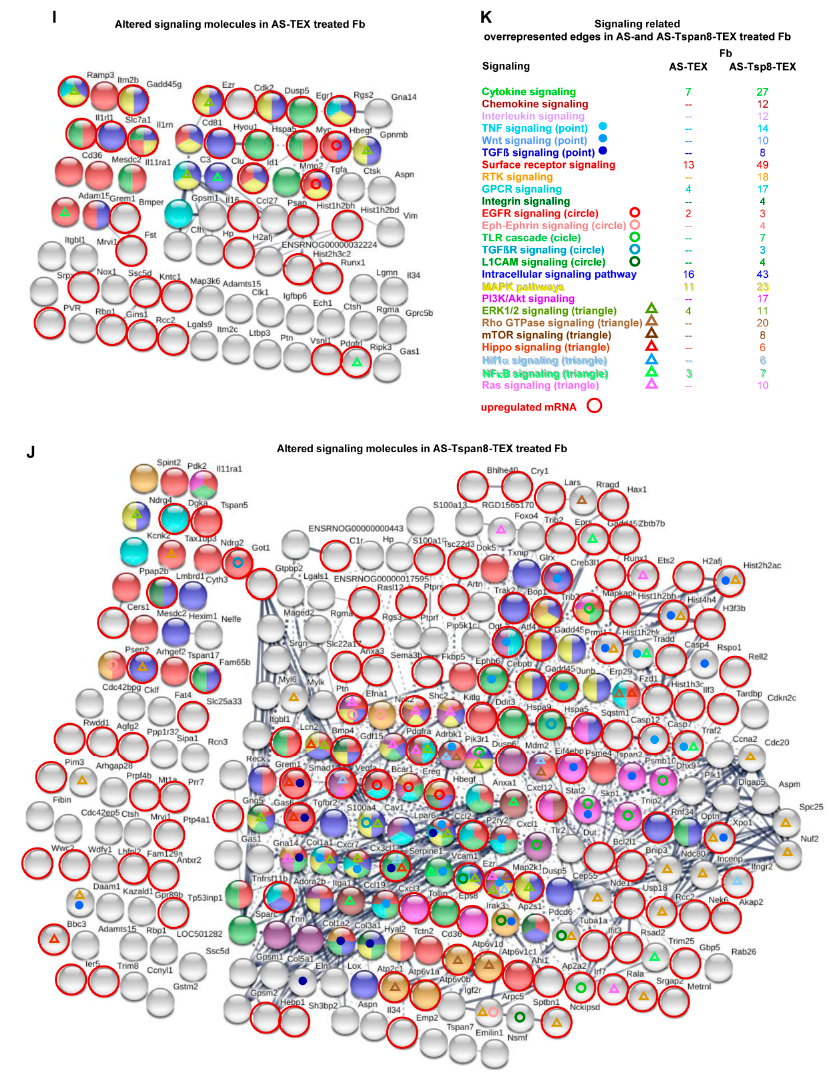
Figure 4. Signaling pathway integration of mRNA up- or downregulated in TEX-treated fibroblasts. mRNA was evaluated in AS- and AS-Tspan8-TEX-treated Fb for up- or downregulation compared to untreated Fb. ( A – D ) STRING functional protein analysis included mRNA with a signal strength ≥ 1000 and ≥ 2-fold di ff erence between untreated and TEX-treated Fb, only connected nodes being shown ( A ) mRNA upregulated in AS-TEX- and ( B ) AS-Tspan8-TEX-treated Fb; ( C ) engagement of overrepresented edges of upregulated mRNA in the regulation of biological processes; ( D ) engagement of overrepresented edges of downregulated mRNA (see Figure S5D) in the regulation of biological processes. ( E ) WB of indicated proteins in untreated, AS- and AS-Tspan8-TEX-treated Fb; ( F ) RTK and non-RTK protein array of Fb and AS-Tspan8-TEX-treated Fb. The mean of duplicates is shown, signal intensity being adjusted to 1 for untreated Fb. A significant increase in signal strength ≥ 1.5-fold is indicated by a grey * and by ≥ 2-fold by a black *; ( G ) Fb were seeded on top of matrigel-coated transwell plates that contained RPMI / 10% FCS or RPMI / 30 µ g / mL AS- or AS-Tspan8-TEX. After 48 h, cells at the lower membrane site were fixed and stained with crystal violet, light microscopy appearance (scale bar: 20 µ m). ( H ) WB of the indicated proteins in Fb, AS- and AS-Tspan8-TEX-treated Fb; ( I – K ) STRING functional protein analysis for signaling engaged molecules up- or downregulated in ( I ) AS- and ( J ) AS-Tspan8-TEX-treated Fb, upregulated mRNA being indicated by a red circle; ( K ) overrepresented edges for signaling-related molecules and processes, the number of mRNA in overrepresented edges is shown. Full name of gene symbols: Table